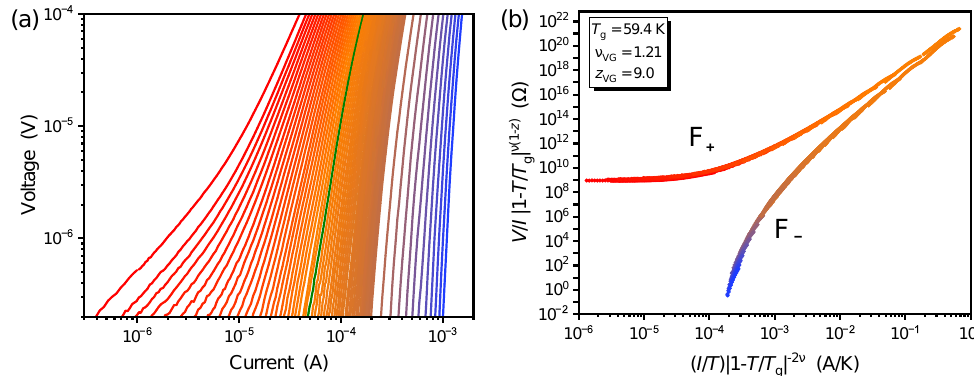
Figure 2. ( a ) V - I isotherms at 66K (red), 65.5 to 52K in 0.25K steps, and 50 to 30K (blue) in 2K steps of the nanopatterned sample at the matching field B 1 = 2.653T. The green line indicates the isotherm at 59.5K, which is closest to the glass temperature T g = 59.4K. ( b ) V / I vs. I isotherms plotted according to the VG scaling of Equation (2). The isotherms collapse onto the two universal functions F + above and F − below T g , respectively. The colors of the data points represent the temperature and are the same as in panel ( a ).